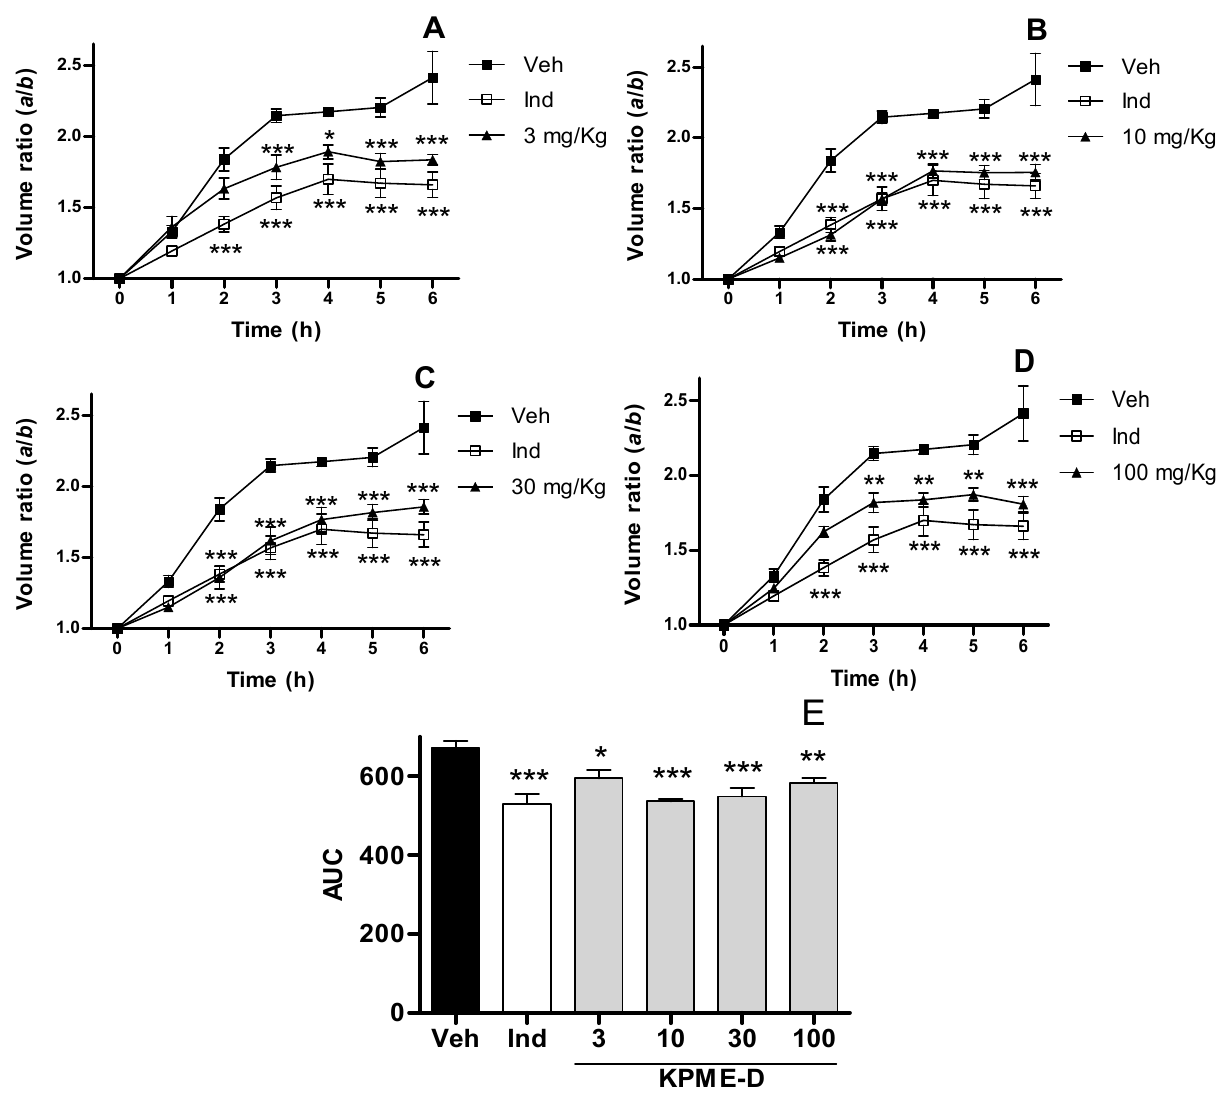
Figure 2. (a – d ) Time-effect curves of KPME-D on carrageenan induced oedema in volume ratio a / b , where a and b are the volumes of right paw after and before carrageenan treatment ± SEM, so each rat is its own control for time = 0, n > 6, treatments are statistically different; ( e ) Anti-inflammatory effect of KPME-D on carrageenan induced paw edema. Data represent the mean of area under curve of volume ratio of hourly determinations 1–6 h ± SEM, n > 6. Veh (vehicle), Ind (indomethacin). * p < 0.1, ** p < 0.01, *** p <